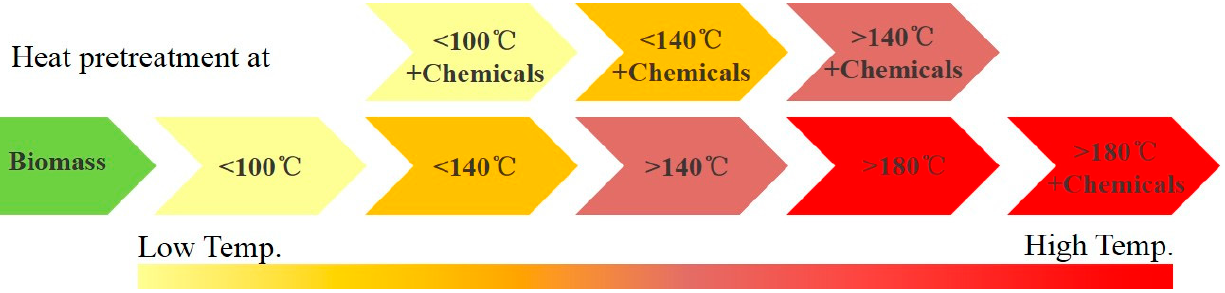
Figure 1. Heat treatment interval according to